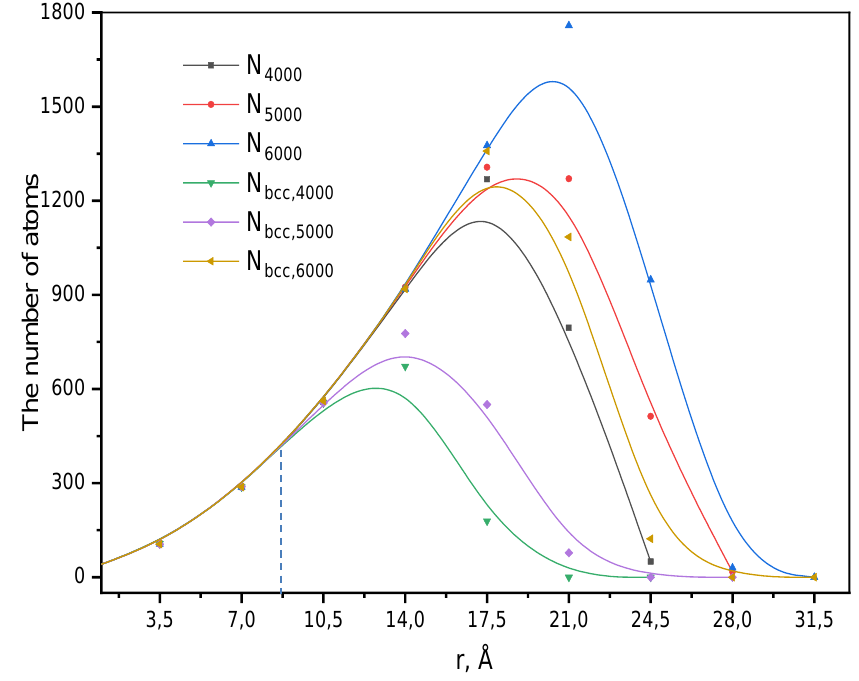
Figure 7. Distribution of atoms, bcc-atoms for 4000, 5000, 6000 atoms sample through concentric spherical at 900